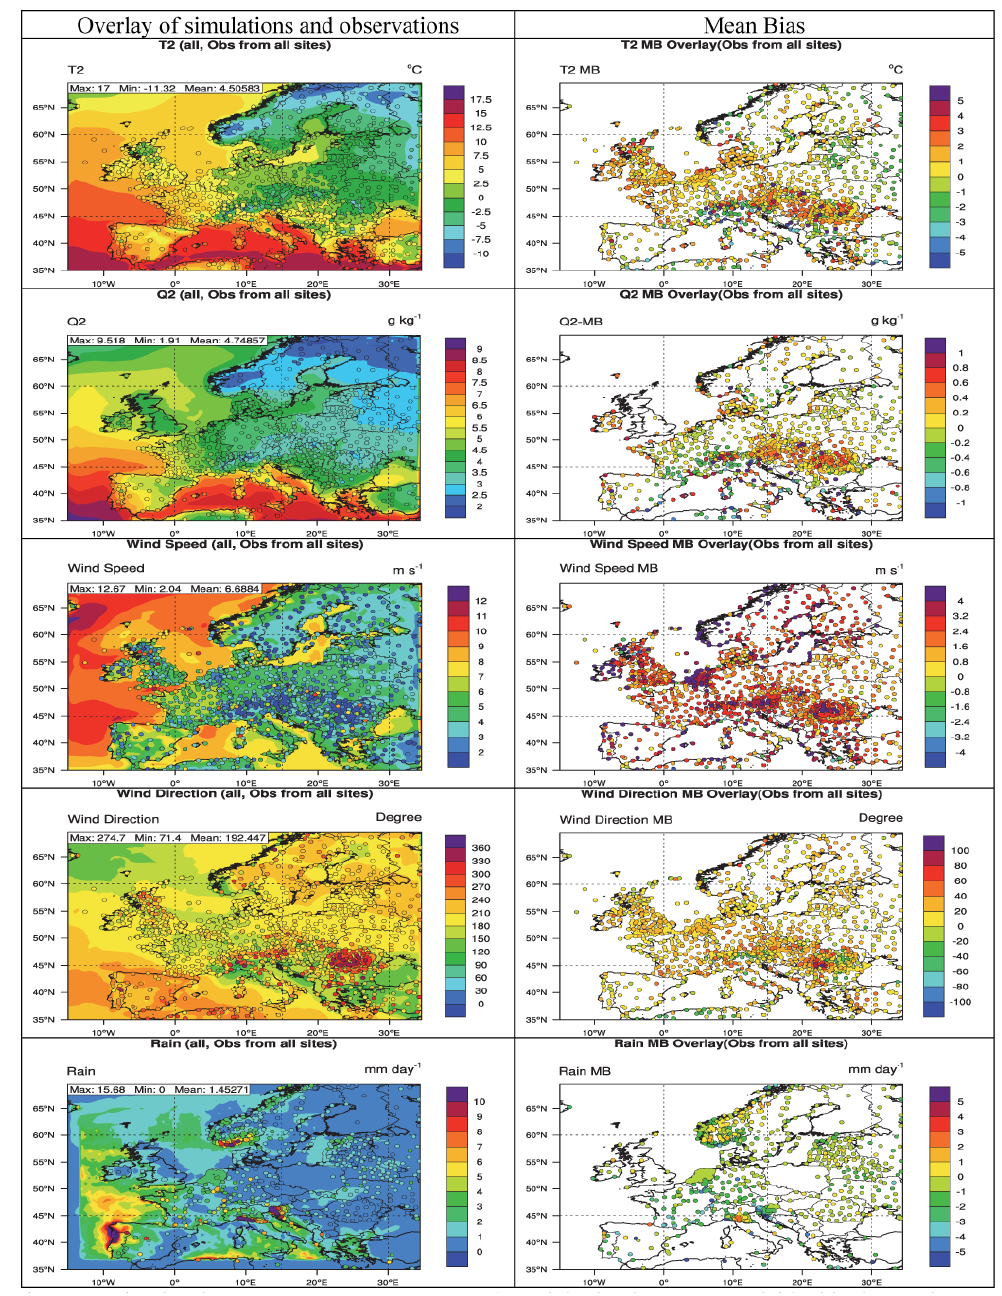
Fig. 3. Simulated T2, RH2, WSP10, WD10, and precipitation by WRF overlaid with observations in January 2001 (left column) and their associated mean biases (right column). Note that for WD10, 0 degree is equivalent to 360 degrees in the wind rose